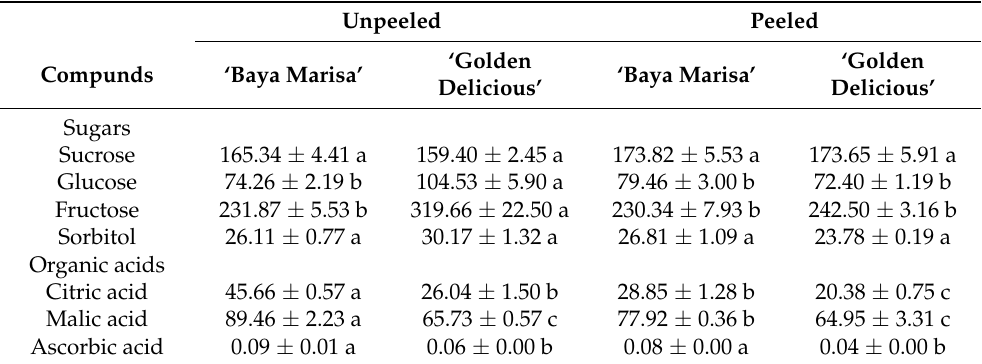
Organic acids Citric acid 45.66 ± 0.57 a Malic acid Ascorbic acid 0.09 ± 0.01 a 0.06 ± 0.00 b 0.04 ± 0.00